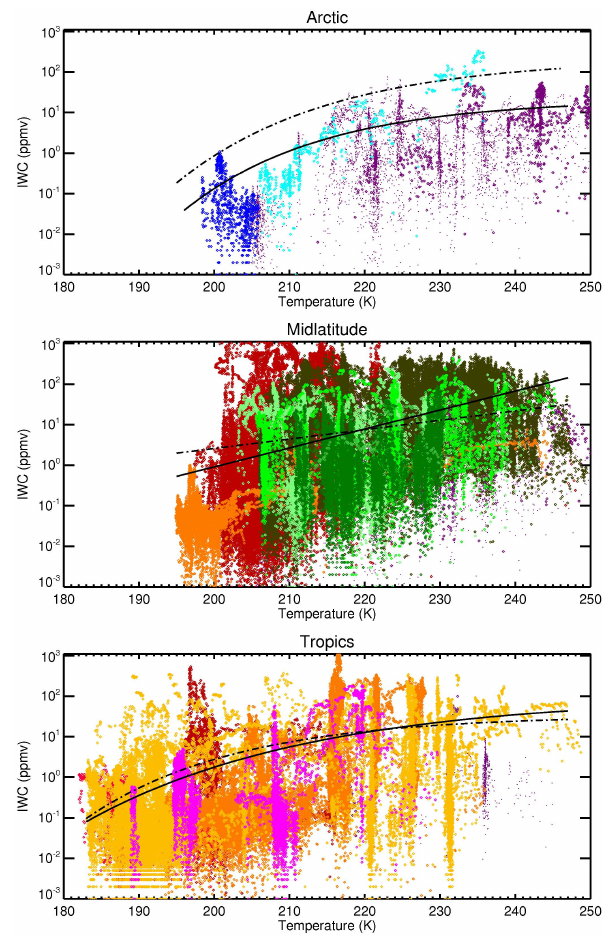
Fig. 6. IWC as a function of temperature and geographic region. Color scheme as in Fig. 3. Data points represented as small dots are a combination of geographic locations and thus included in two plots (see text). The black line represents the median fit, while the dashed black line is the median fit from Schiller et al. (2008). It should be noted that the median fit lines from the Schiller climatol- ogy include convective